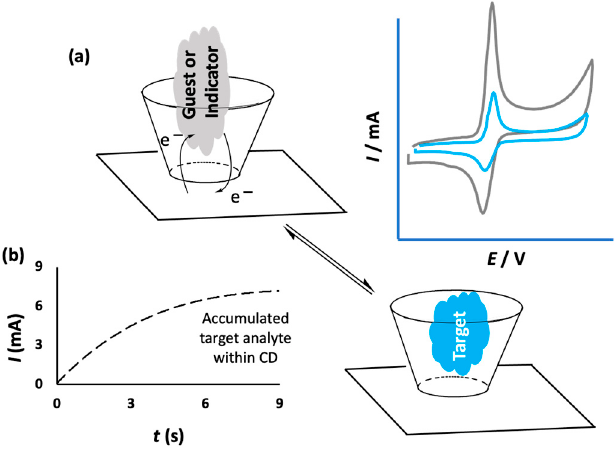
Figure 3. ( a ) Schematic of electron transfer for an included electroactive molecule and its exchange with a nonelectroactive target and the corresponding reduction in measured current; ( b ) the in- creasing current recorded following an accumulation